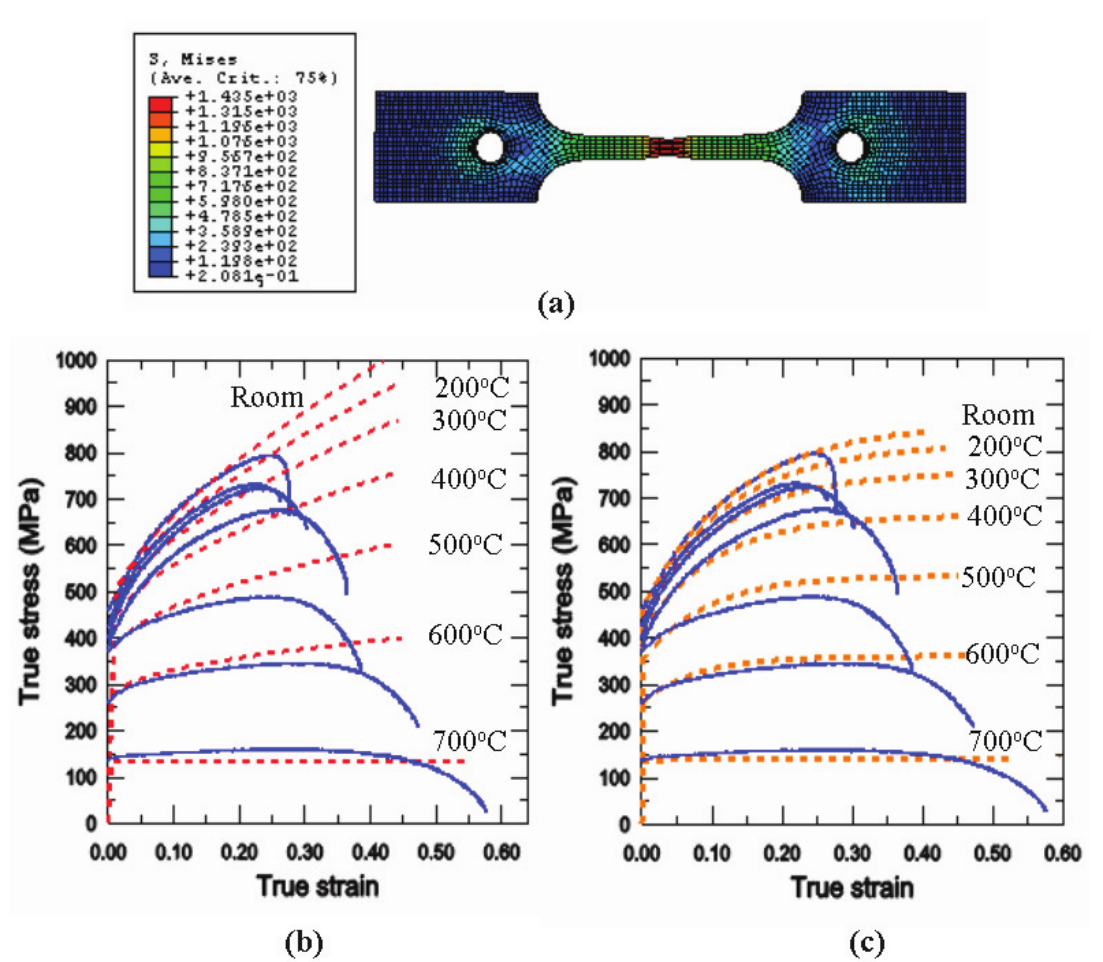
Figure 9. FEM results of (a) tensile deformation, (b) Ludwick’s hardening and (c) Voce’s hardening at elevated tempera-